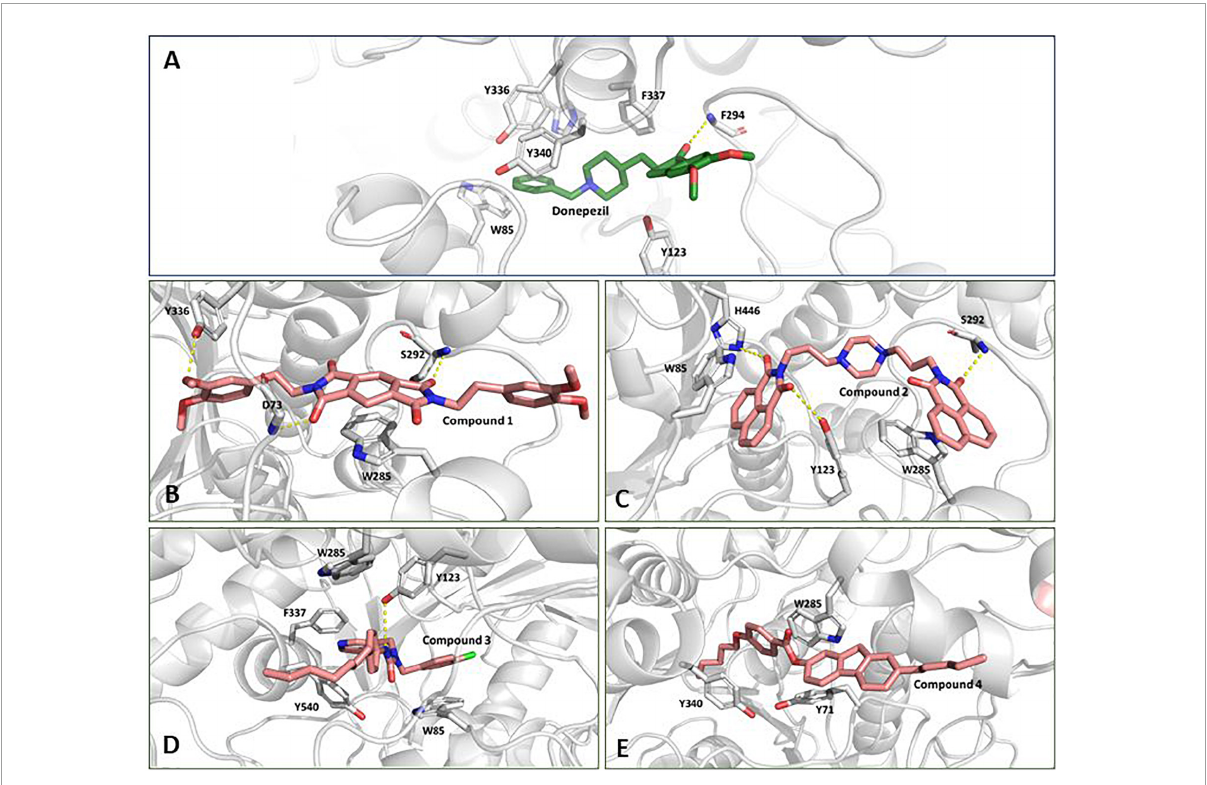
FIGURE5 Conformation of (A) Donepezil, (B) Compound 1, (C) Compound 2, (D) Compound 3, and (E) Compound 4 in the AChE protein active site (ribbon representation) showing intermolecular interaction.